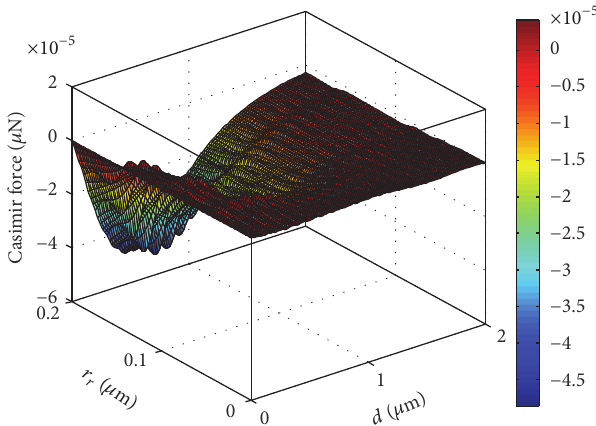
Figure 3: The repulsive Casimir force as a function of different minor radius of ellipsoid and different separation between metallic ellipsoid and plate.